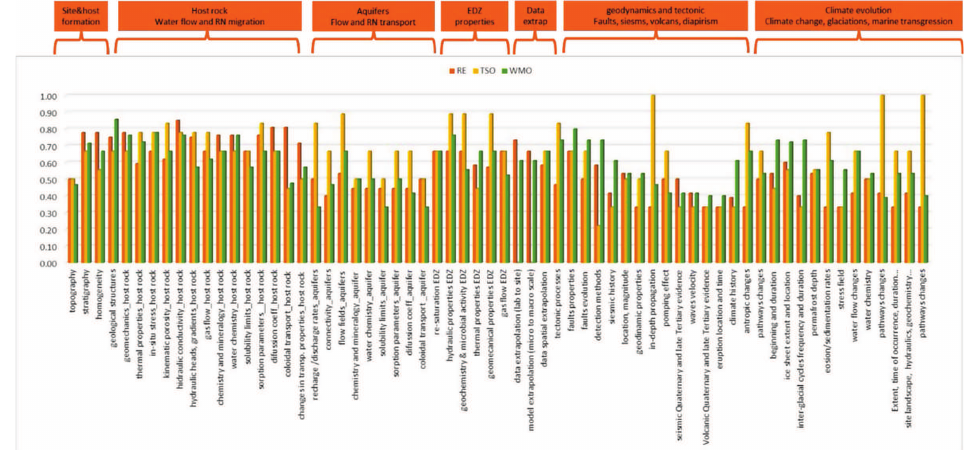
Fig. 7. Distribution of “significance for safety” level for geological disposal (low: < 0.33; medium: 0.33-0.66; high: >